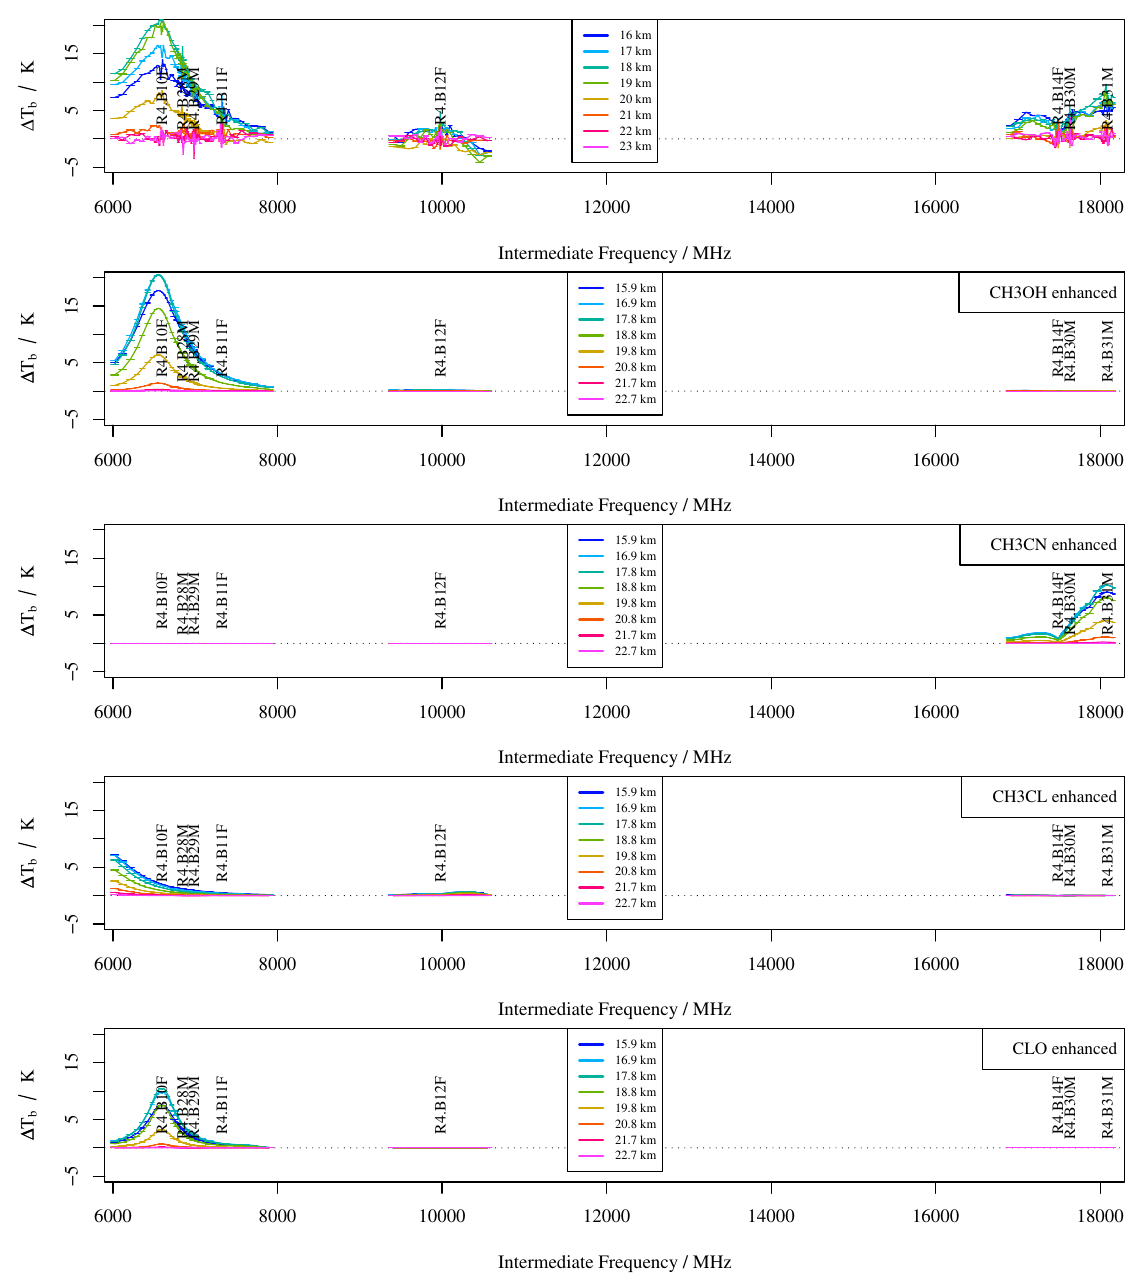
Fig. 8. Spectra from the 640GHz radiometer (R4) of MLS, plotted in the same manner as in Fig. 7. The top panel is the measured difference between spectra in the plume and out of it. The other four panels show the difference between a default calculated spectrum and ones for which CH 3 OH, CH 3 CN, CH 3 Cl and ClO are enhanced by roughly the amount observed in the retrieved